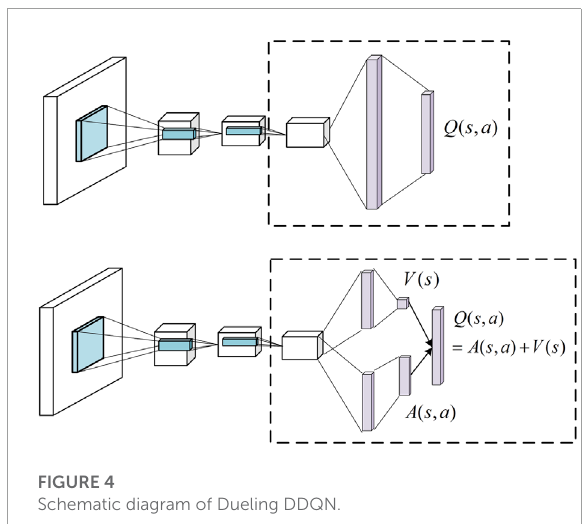
FIGURE 4 Schematic diagram of Dueling